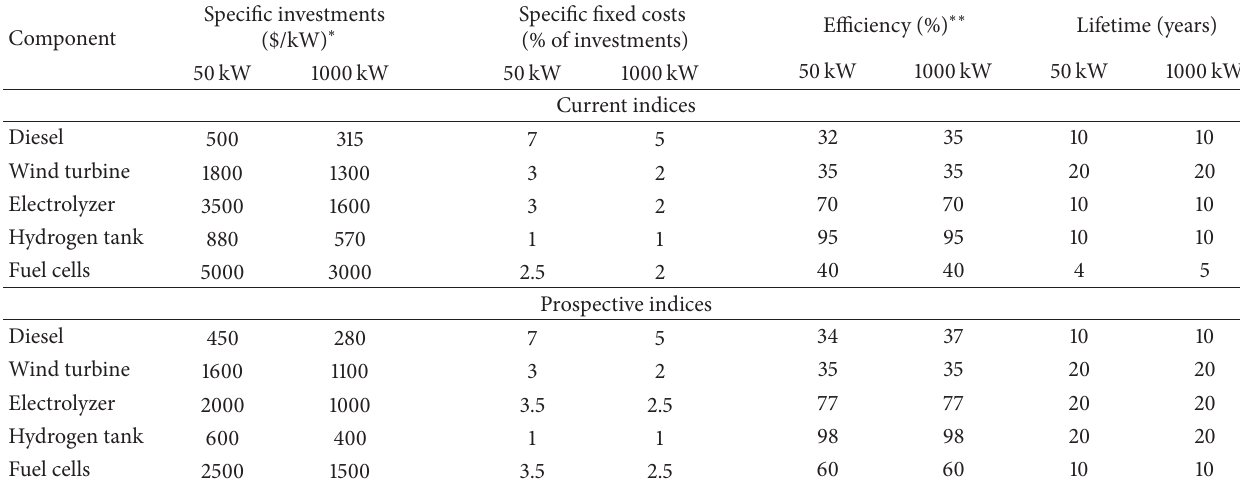
∗ Specific investments for the hydrogen tank are given in $/m 3 ; ∗∗ efficiency of wind turbines is given for information (the calculations use wind turbine characteristics (power curve)).